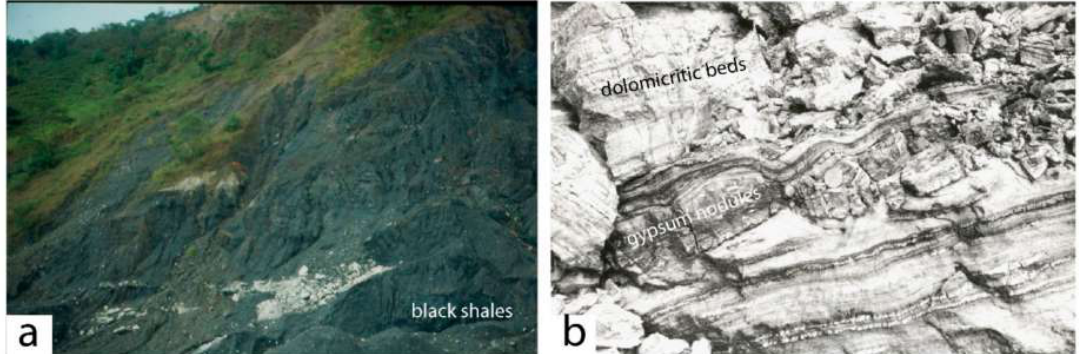
Figure 24. Evaporites in the the Chivor mining area: ( a ) The gypsum deposits present decametric lenses of white gypsum/dolostone alternations hosted in a black matrix made of crushed and dismembered black shales similar to the main evaporitic regional breccia level in emerald deposits; ( b ) Dolomicritic beds are in alternation with nodulated beds of gypsum. Photographs: Yannick